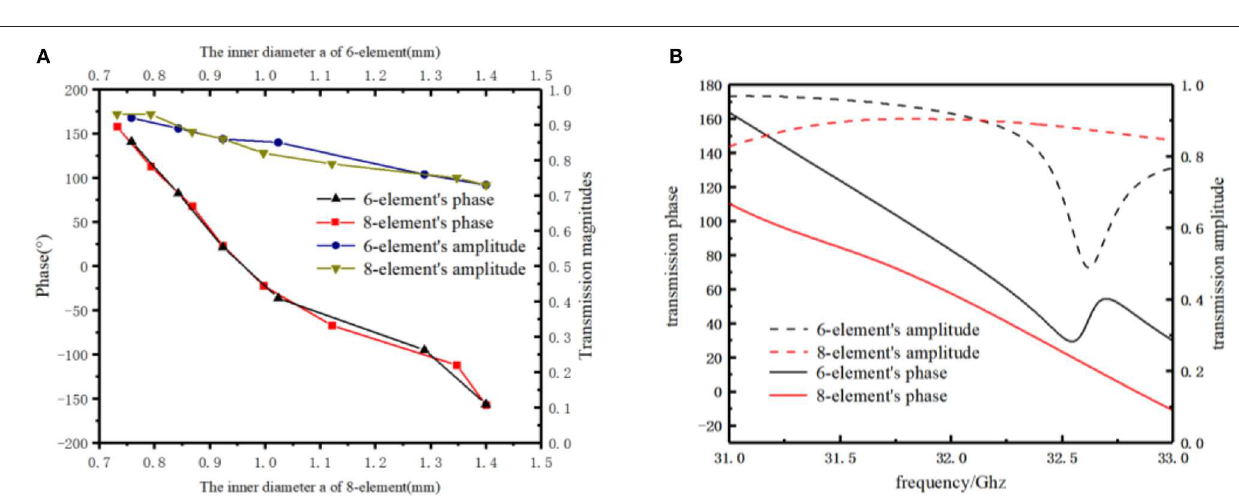
phase gradient changing on the deflection surface. Figure 3B shows the transmission amplitude and the transmission